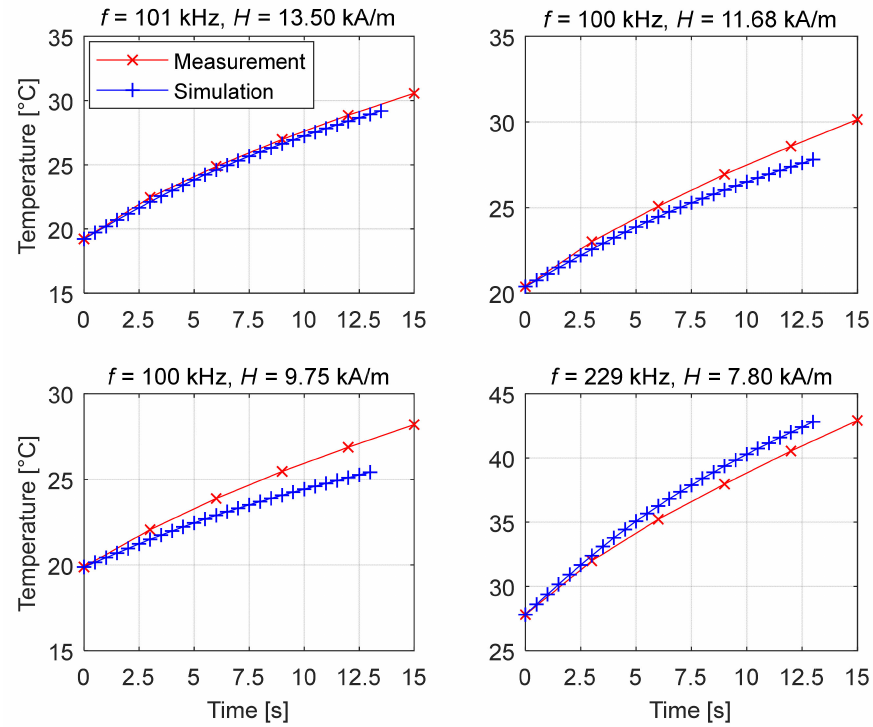
Figure 13. Comparison of time–temperature of measurement and simulation at the selected point.